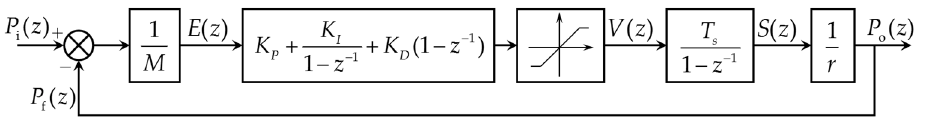
Figure 23. The block diagram of the control system.